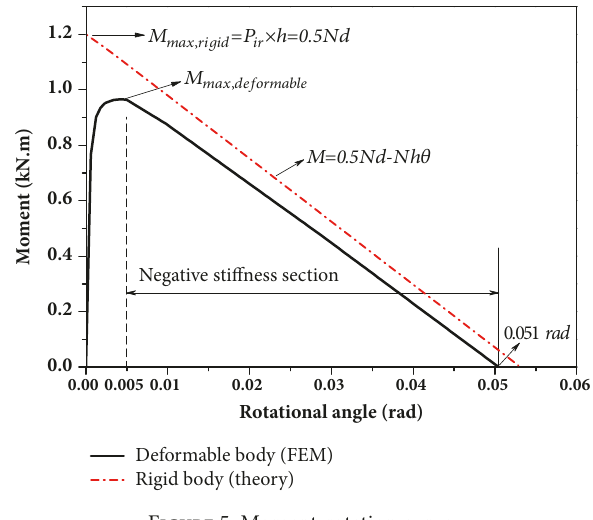
Figure 5: Moment-rotation